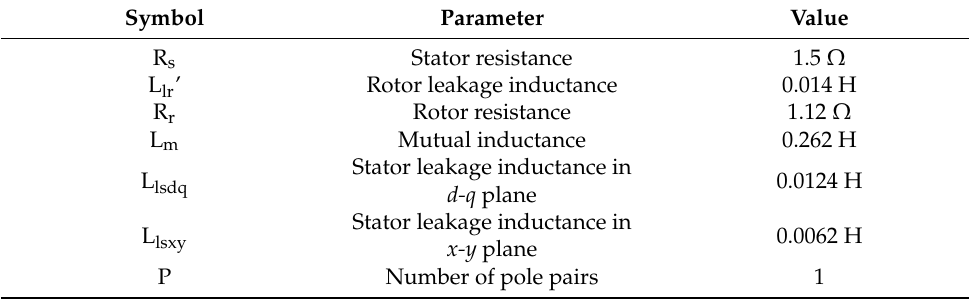
Figure 6. The control block diagram of FOC. Table 6. Parameters of the induction motor.